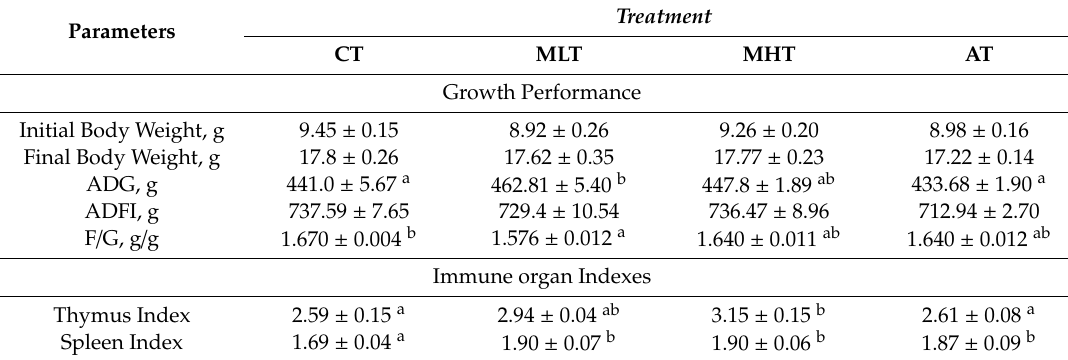
Table 2. E ff ects of dietary mulberry leaf polysaccharides (MLPs) on growth performances and immune organ indices of weanling pigs.